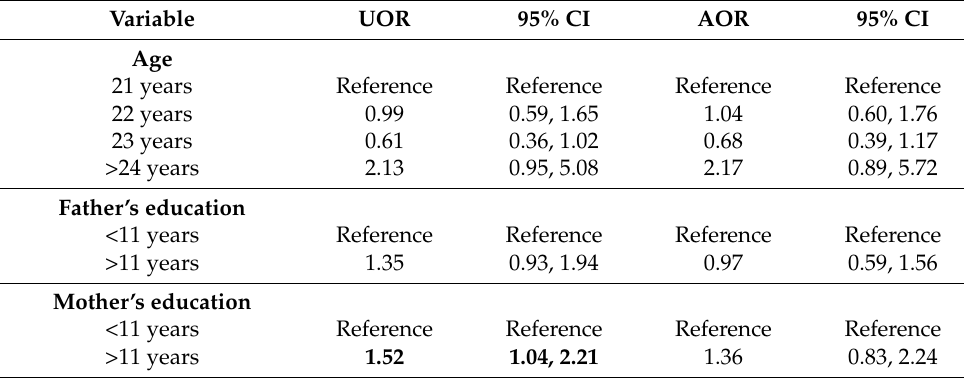
Table 4. Factors associated with experience of any type of ragging among the second- and third-year students from the faculties of medicine and